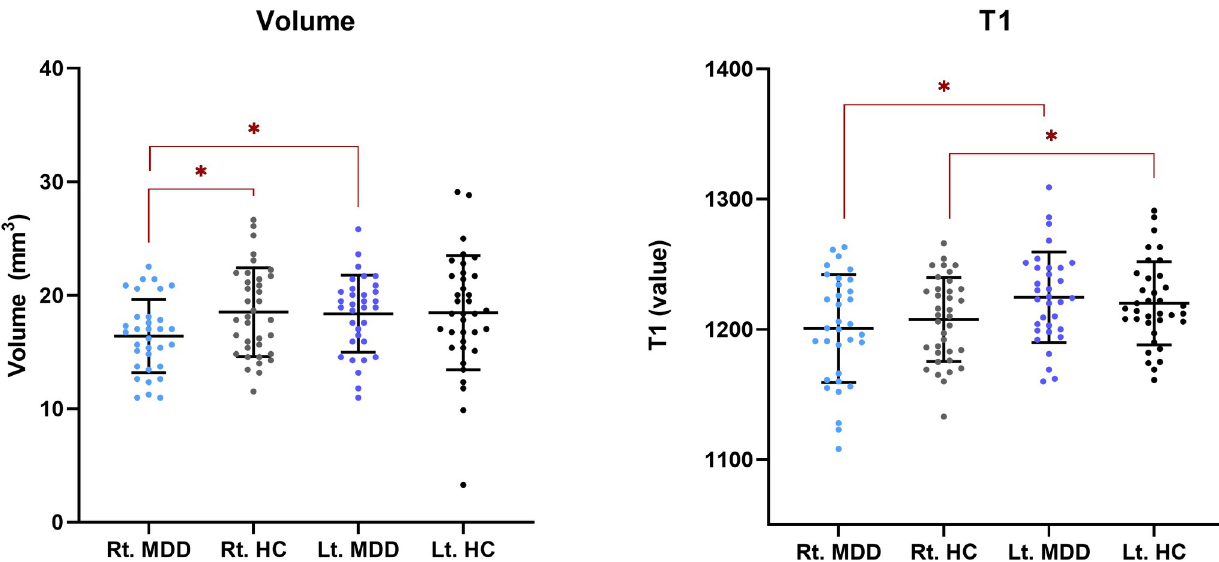
Fig 3. Scatter plot with the mean and standard deviation of the volume and T1 value of the right and left habenula in each group. Volumes or T1 value of the hemispheric habenula (Y axis) for the diagnostic groups (X axis). The graph plots the individual data points with a horizontal line superimposed at the mean and error bars showing plus and minus one SD of each group. We drew red lines between the combinations that differed significantly and marked them with an asterisk ( � ). Please note the smaller right habenula volume in the MDD group than the left habenula volume in the MDD group and those of the right and left habenula in HCs. Also, note that the T1 value in both the HC and MDD groups is lower in the right habenula than in the left. Abbreviations: Rt, right; Lt, left; HC, healthy control; MDD, major depressive disorder;SD, standard deviation.